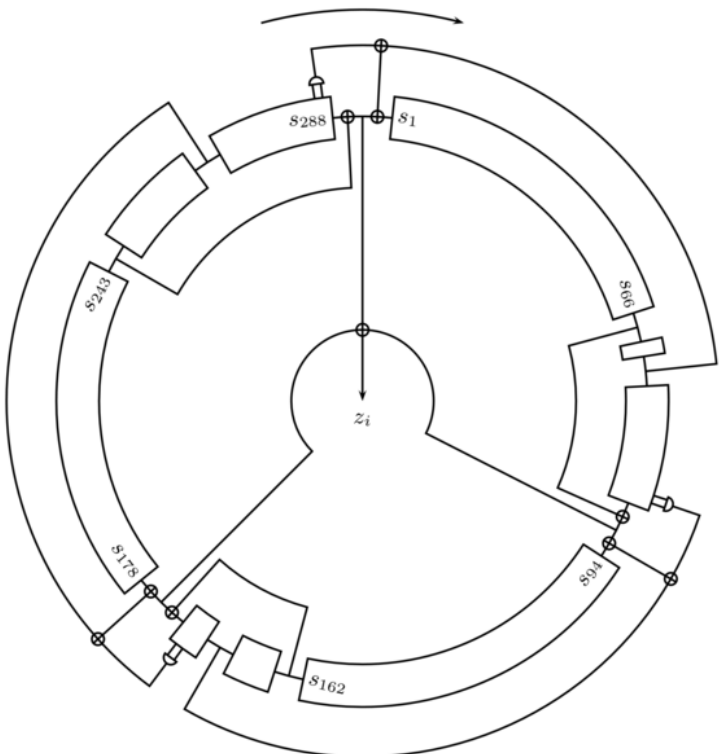
Figure 1. Structure of the trivium algorithm. The main elements are shift registers, AND gates, and XOR